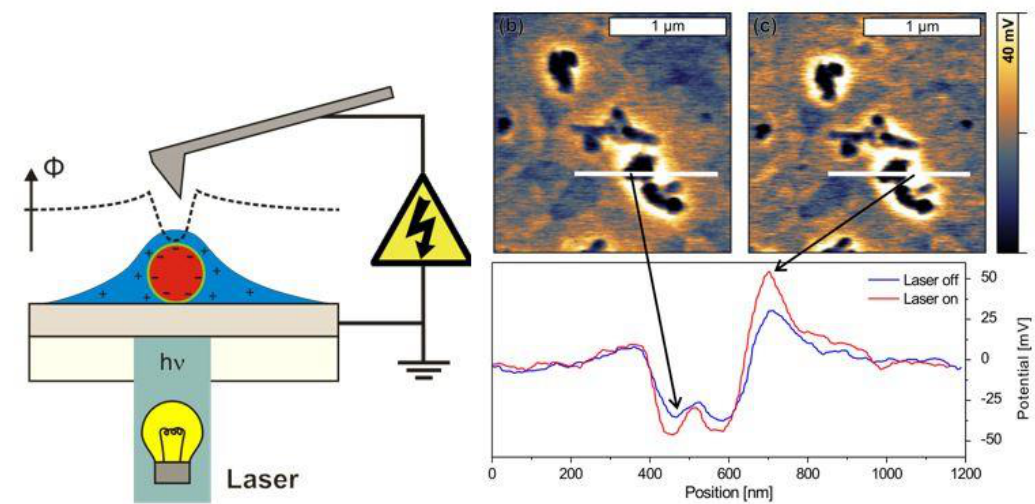
Figure 8. Schematic presentation of Kelvin-probe AFM measurements (left), which allow a determination of charging of nanoobjects and measurements (right), which prove the transfer of electrons from the coated semiconducting polymer to the TiO 2 nanoparticles (see [115–117]); right part reproduced with permission of [115], published by the ACS, 2010.